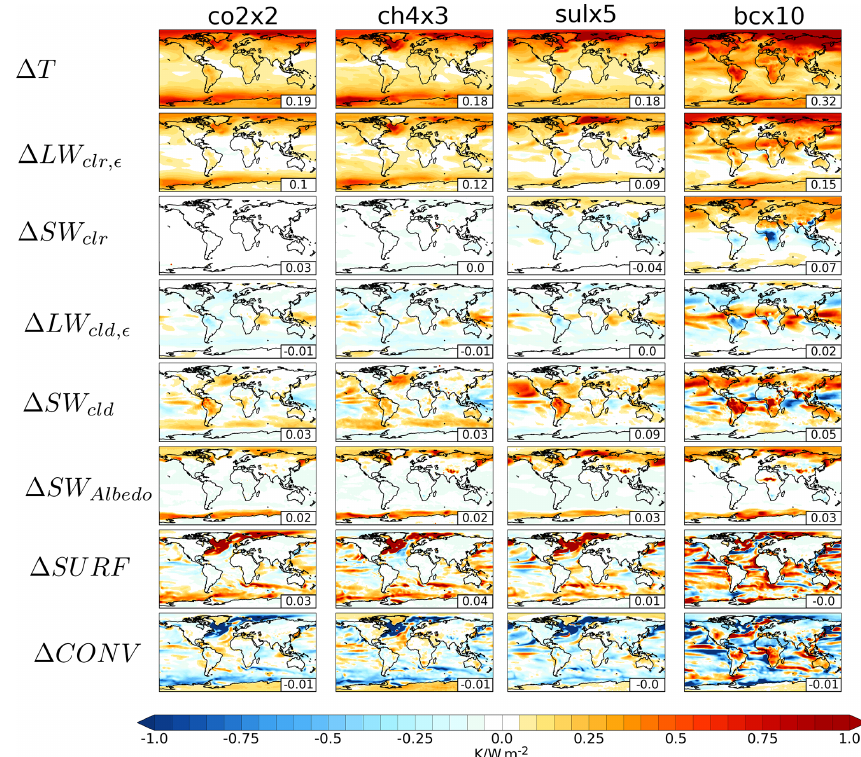
Figure 6. The model-to-model standard deviation of the effective temperature response to different climate perturbations (row 1) and its decomposed different energetic components (rows 2–8). Each column shows results for four different climate forcers, i.e., carbon dioxide (column 1), methane (column 2), sulfate (column 3) and black carbon (column 4). The global mean values are shown at the bottom right corner of each